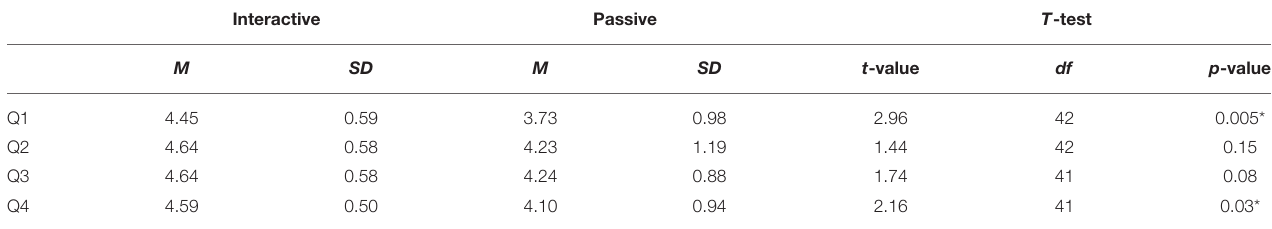
TABLE 4 | Individual questions from the immediacy of control measure. Interactive Passive T